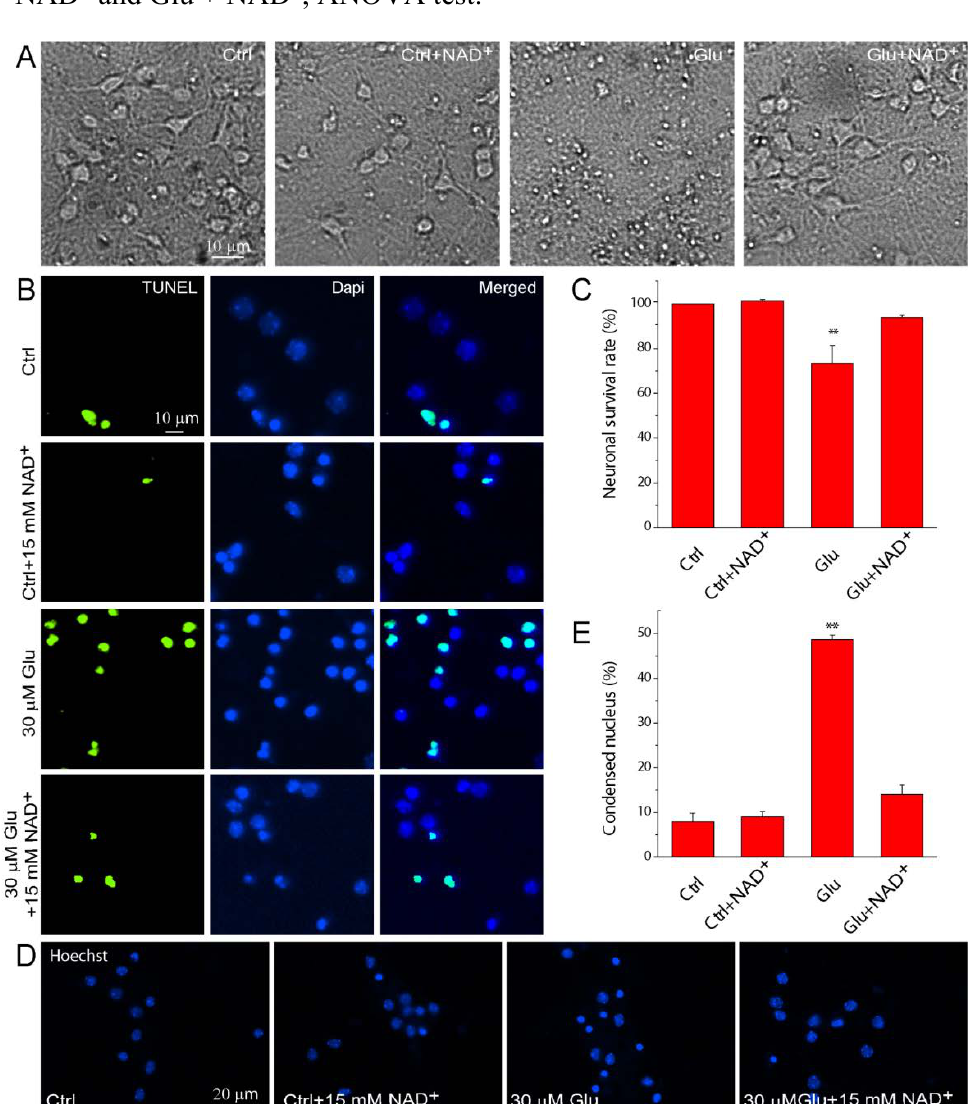
Figure 1. Exogenous NAD + supplementation ameliorates apoptosis in primary mouse neuronal cultures after glutamate stimulation. ( A ) Phase contrast images of mouse cortical neurons without and with treatment of 30 µM glutamate together with 3 μM glycine for 24 h in the presence and absence of 15 mM NAD + ; ( B ) Representative fluorescent images showing the double staining of TUNEL and DNA-binding dye DAPI in neurons. Neuronal cultures were treated with glutamate and NAD + as in ( A ); ( C ) Neuronal survival rates under different conditions; ( D ) Hoechst 33342 nuclear staining in control neurons and neurons exposed to 30 μM glutamate together with 3 μM glycine in the presence and absence of 15 mM NAD + for 24 h; ( E ) Percentages of condensed nuclei based on Hoechst 33342 staining were quantified in each condition. Data are shown as mean ± SE; n = 3 coverslips per experimental condition from 3 independent experiments. ** p < 0.01 versus Ctrl, Ctrl + NAD + and Glu + NAD + , ANOVA